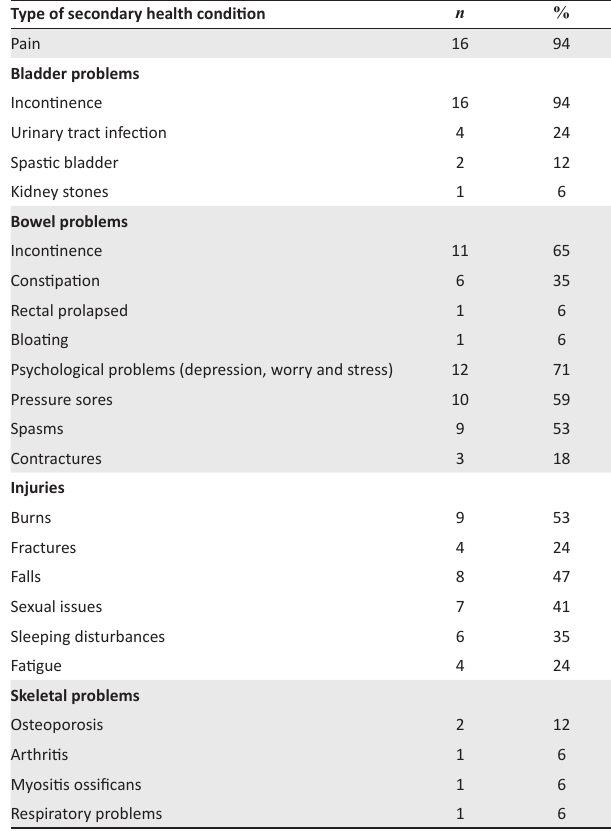
TABLE 2: Range of secondary health conditions experienced ( n =